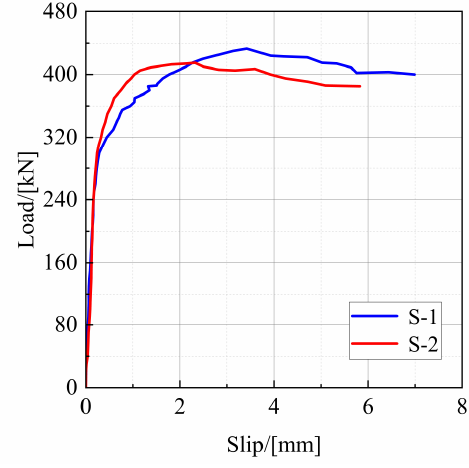
Figure 6. Load-slip curve of push-out specimens.